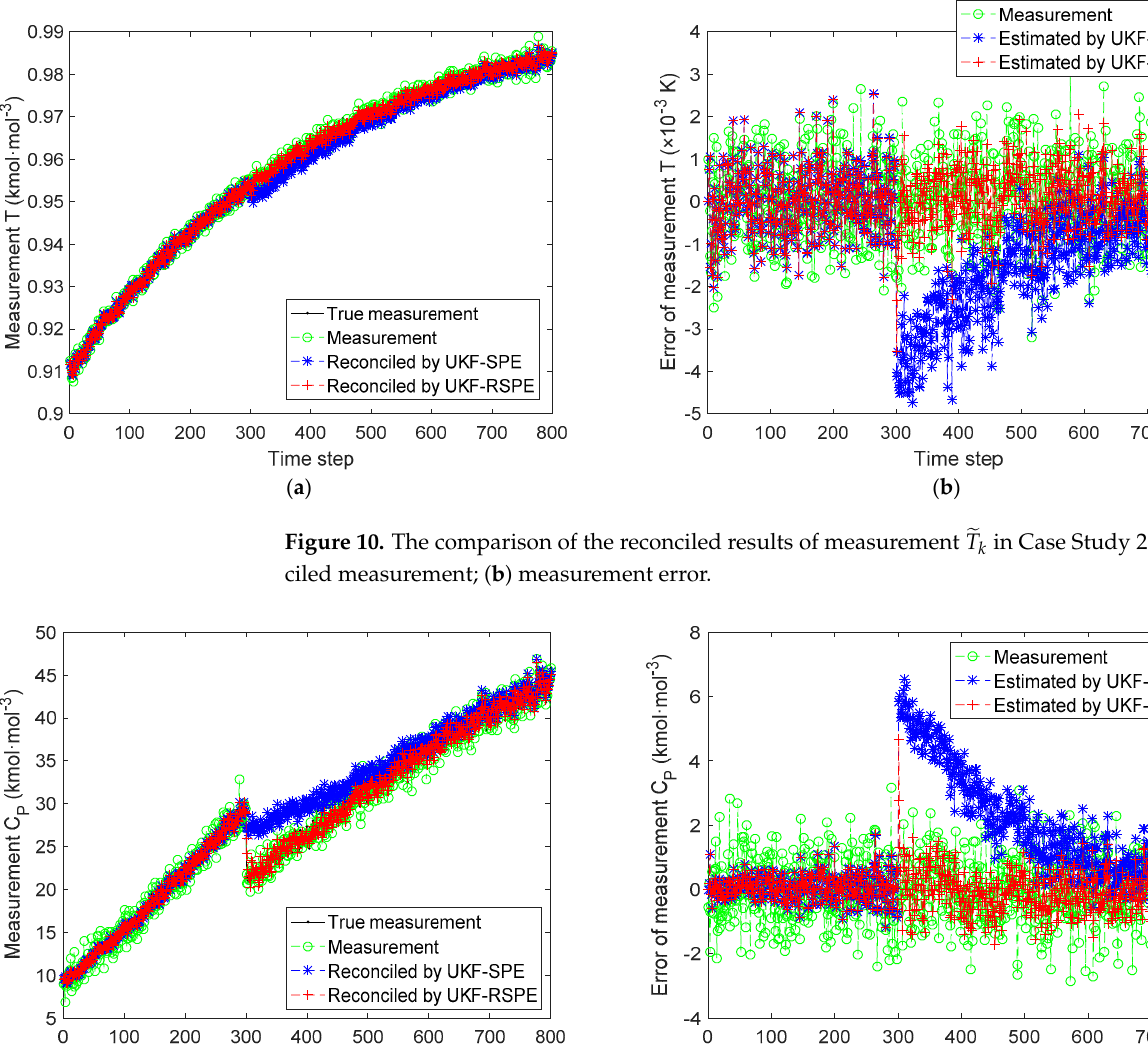
Figure 9. The comparison of the estimated results of parameter f in Case Study 2.1: ( a ) estimated parameter; ( b ) parameter error.